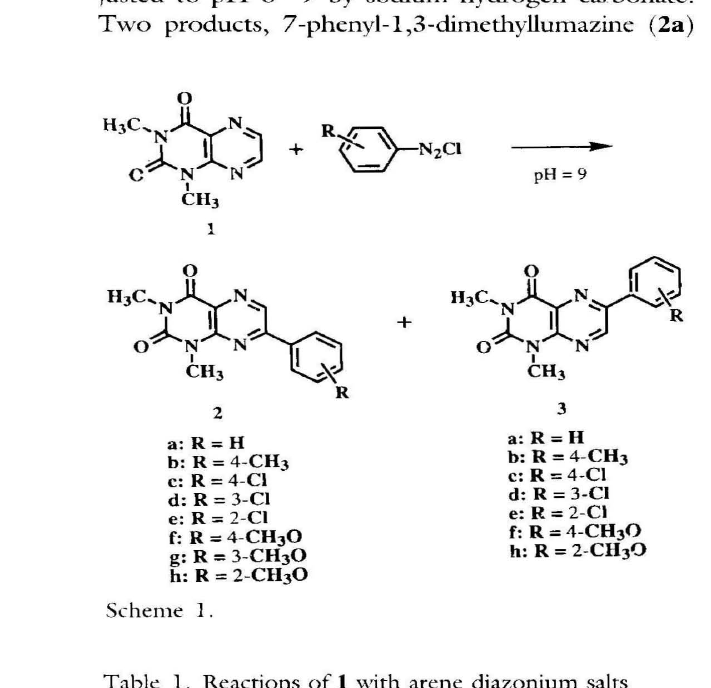
Table 1. Reactions of 1 with arene diazonium salTs